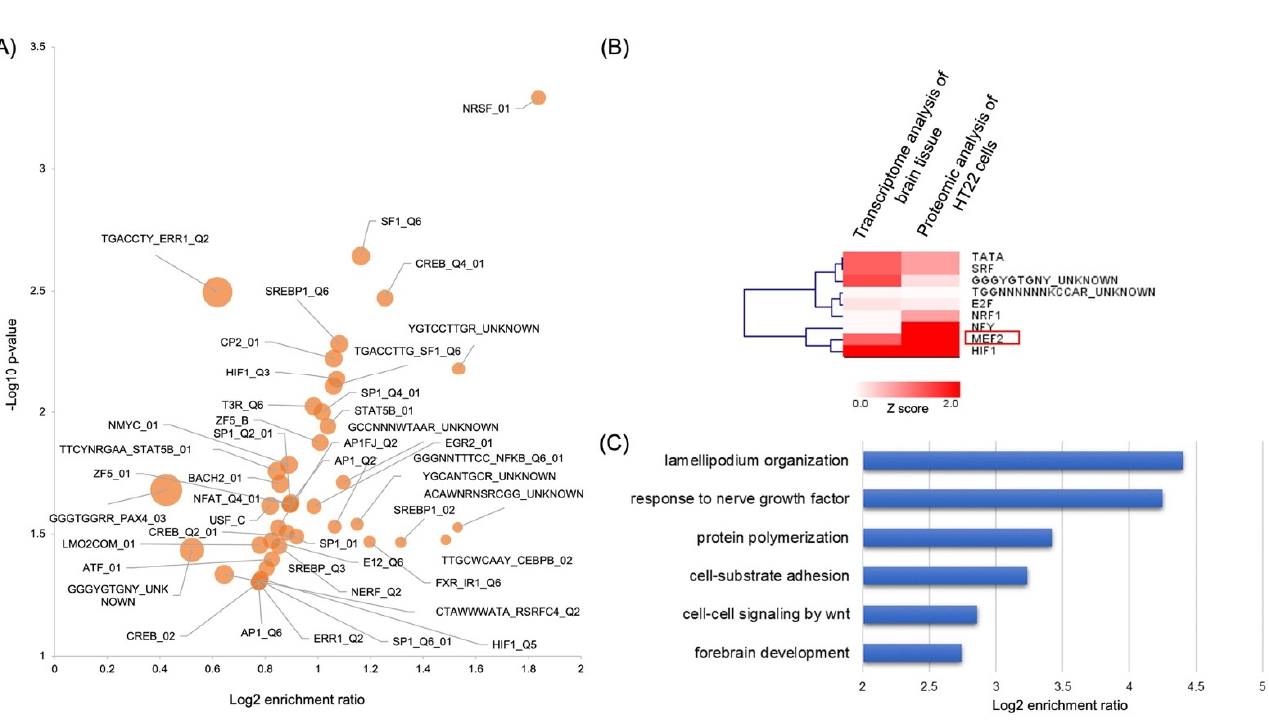
Figure 6. Transcription factor activity enrichment analysis. ( A ) Volcano plot of transcription factor enrichment analysis based on the transcriptome dynamic analysis in ID-induced P15 rat hippocam- pus. ( B ) Enrichment overlapping analysis of transcription factor activities showing a total of nine transcription factors that were activated by iron deficiency in both hippocampal tissue and HT22 cell line. ( C ) Pathway enrichment analysis of MEF2 targets quantified in the tissue transcriptome analysis.